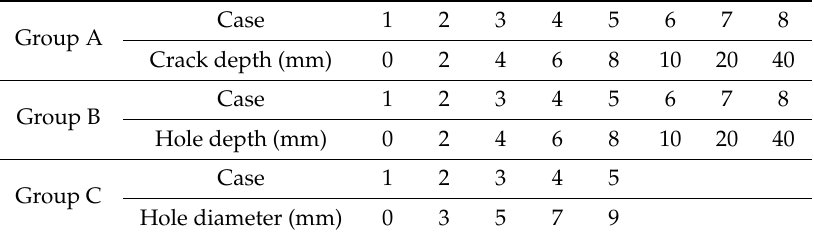
Table 1. Test cases of specimens in Groups A, B, C.